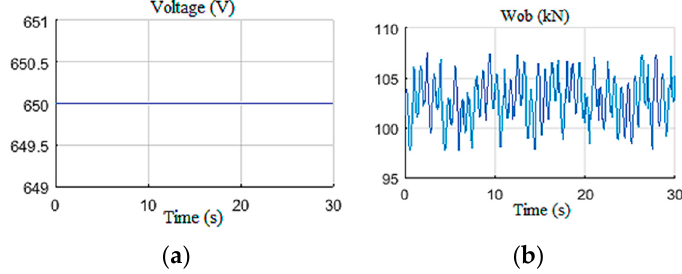
Figure 14. The input of the observer in Scenario 2: ( a ) voltage; ( b ) weight on bit.